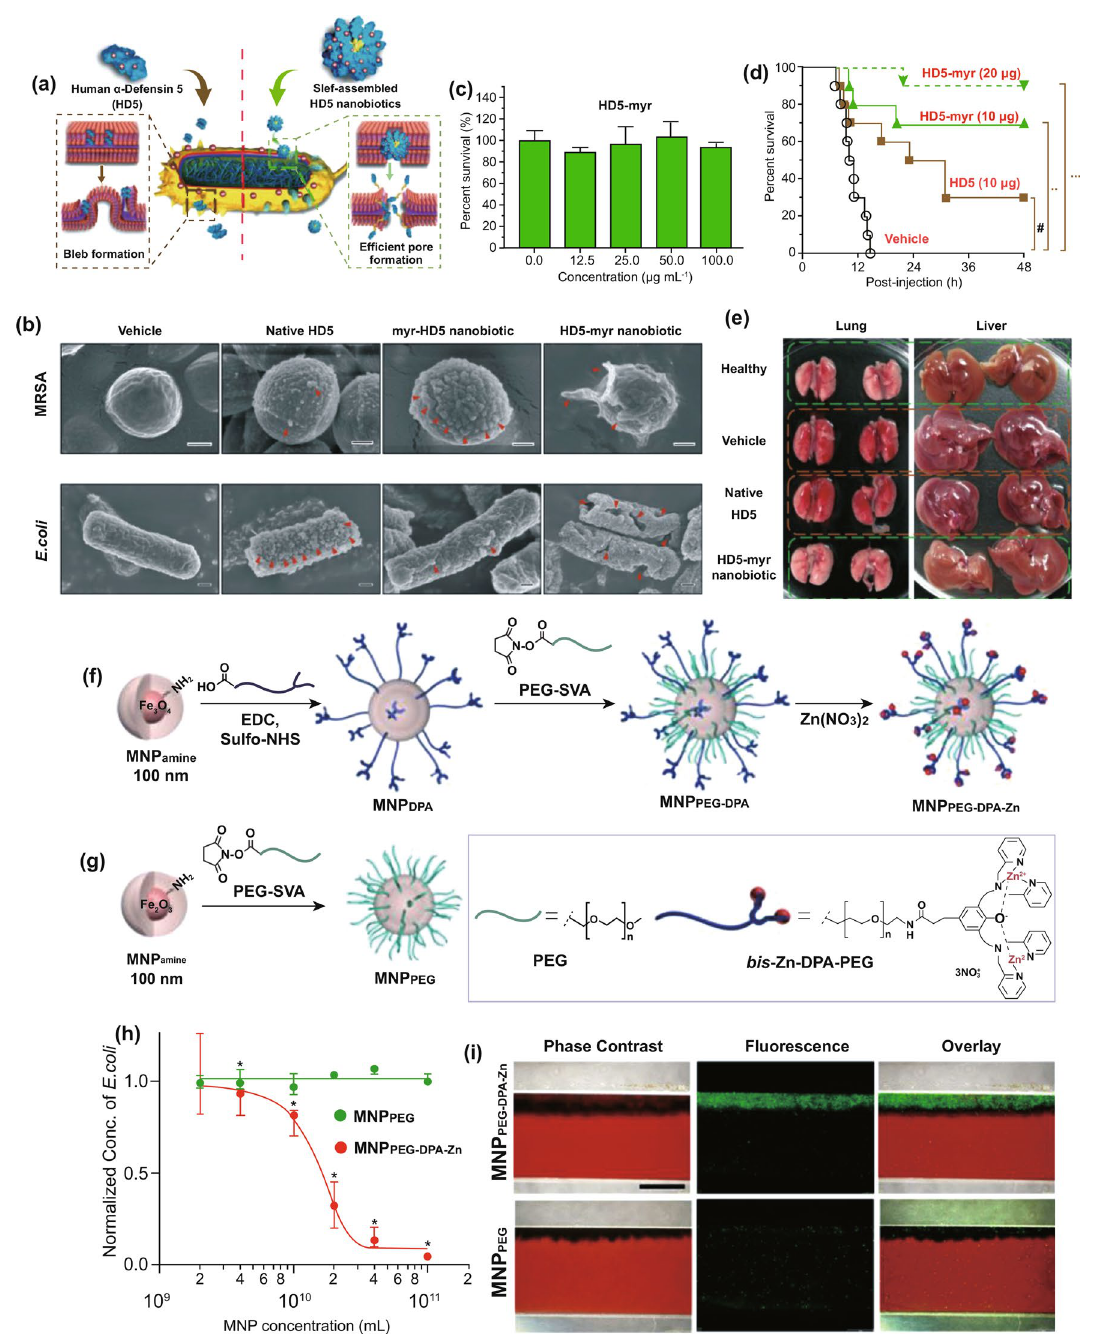
Fig. 12 Self-assembled myristoylated HD5 as a potent nanobiotic improving sepsis outcome. a Schematic illustration of the bactericidal activity of HD5 and HD5 nanobiotics. b SEM observation of the membrane alteration of MRSA and E. coli after incubating with vehicle, native HD5 or nanobiotics. c MTT assay demonstrating the neglectable cytotoxicity of HD5-myr to RAW264.7 cells. d Survival rates of intraperitoneally chal- lenged E. coli -induced septic mice undergoing different therapeutics including vehicle, HD5 and HD5-myr nanobiotics. e Photographs of lungs and livers from healthy mice and septic mice after treatment with vehicle, HD5 or HD5-myr nanobiotics. Reproduced with permission from Ref. [55]. Copyright 2018 American Chemical Society. Synthetic ligand-coated magnetic nanoparticles separating bacteria from blood with the help of a microfluidic chip. f Design and fabrication of MNP PEG-DPA-Zn . g Design and fabrication of MNP PEG . h Concentration-dependent effect of MNP PEG-DPA-Zn and MNP PEG on the separation of E. coli from PBS. i Phase contrast and fluorescence micrographs of distribution of magnetic nanoparticles and bacteria. MNP PEG-DPA-Zn (dark in phase contrast) colocalized with E. coli (green fluorescence), while MNP PEG accumulated without E. coli. Reproduced with permission from Ref. [225]. Copyright 2014 American Chemical